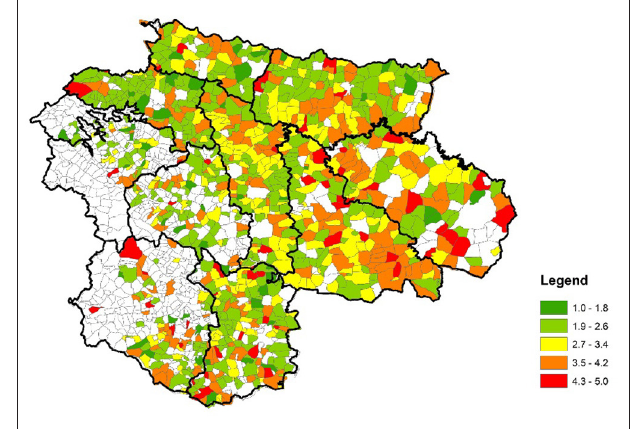
FIGURE 6 | Water service sustainability index.